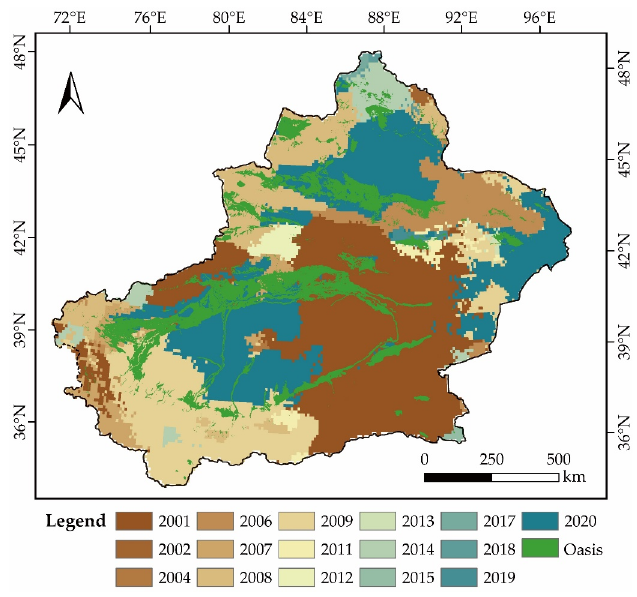
Figure 6. Years corresponding to the minimum annual precipitation in Xinjiang from 2001 to 2020.